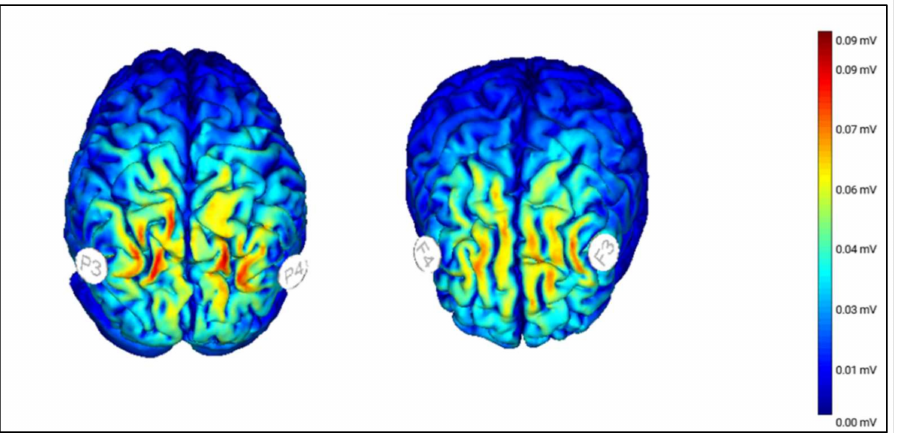
Figure 2. Map of electric field magnitudes in a male brain model from the frontal ( right ) and parietal views ( left ). Stimulating electrodes will be placed over the bilateral dlPFCs ( right ) and bilateral PPCs ( left ) and will be induced with a current with amplitudes varying randomly between − 0.375 and 0.375 mA while oscillating at frequencies between 100 and 500 Hz. The actual stimulation will last for 20 min, whereas the sham stimulation will consist of a current ramping up and down within 30